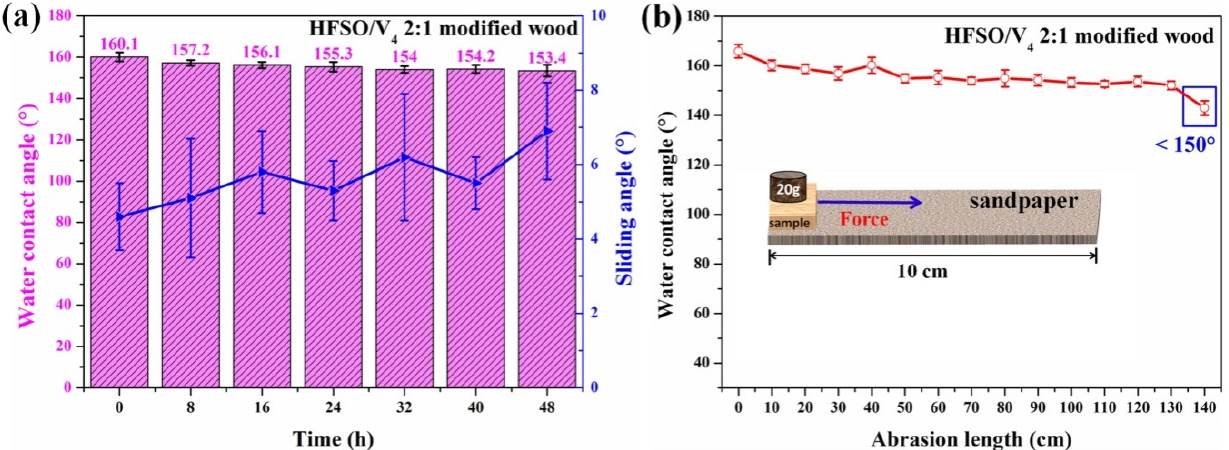
Figure 6. The durability test of superhydrophobic silicone resin coating on modified wood surface. ( a ) Variation of the WCA and SA under 70% relative humidity at 50 ◦ C; ( b ) sandpaper abrasion